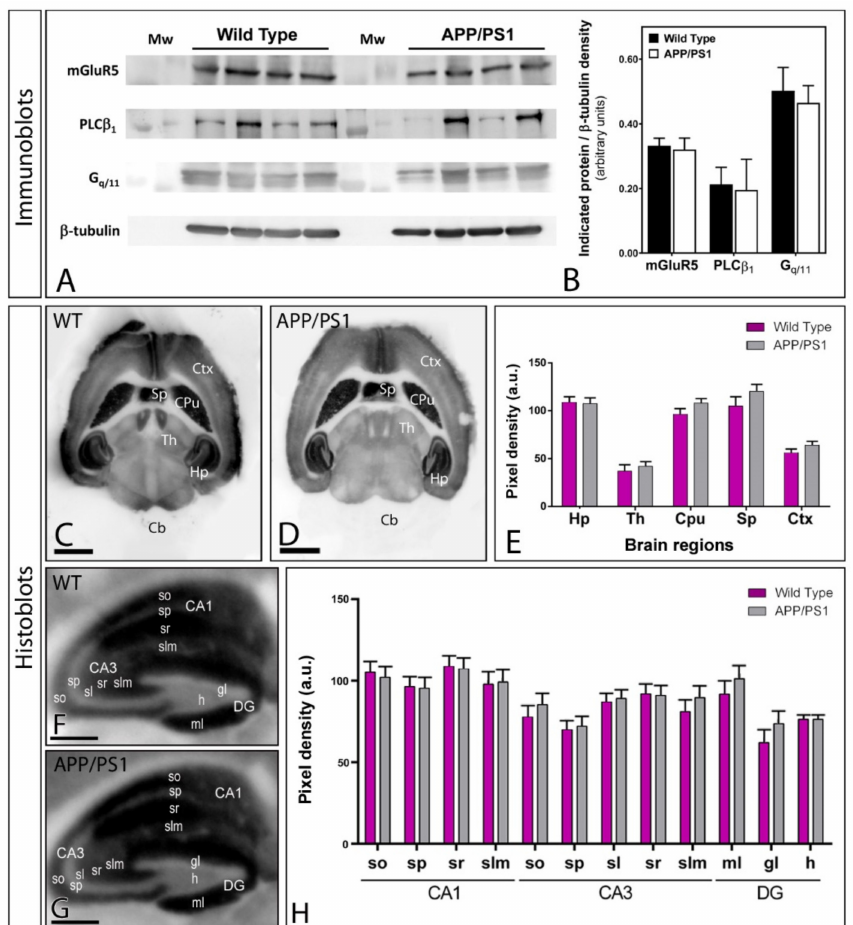
Figure 1. Expression of mGlu 5 in wild type and APP/PS1 mice. ( A , B ) Immunoblots showing the ex- pression of mGlu 5 , PLC β 1 and G q/11 in hippocampal membranes from APP/PS1 and wild type mice at 12 months of age. The developed immunoblots were scanned and densitometric measurements from three independent experiments were averaged together. Quantification of the three proteins were normalised to β -tubulin and expressed as pixel density, showing no differences in APP/PS1 mice compared to age-matched wild type controls. ( C – E ) The regional brain mGlu 5 expression was visualised in histoblots of horizontal brain sections at 12 months of age in wild type and APP/PS1 mice using an affinity-purified anti-mGlu 5 antibody. The expression of mGlu 5 in different brain regions was determined by densitometric analysis of the scanned histoblots. The expression of mGlu 5 revealed marked region-specific differences, with the strongest immunoreactivity in the hippocam- pus (Hp), caudate putamen (CPu) and septum (Sp), and moderate labelling in the cortex (Ctx) and thalamus (Th). The weakest expression level was detected in the cerebellum (Cb). Densitometric analysis showed no differences in mGlu 5 expression in APP/PS1 mice compared to age-matched wild type controls at the ages employed. ( F , G ) Hippocampal expression and distribution of mGlu 5 in wild type and APP/PS1 mice visualised in histoblots of horizontal sections at 12 months of age. ( H ) Expression for mGlu 5 was strong in all dendritic layers of the CA1 and CA3 region and DG, with the strata oriens (so) and radiatum (sr) of the CA1 region showing the highest expression levels. A more moderate expression was observed in the stratum lacunosum-moleculare (slm) of CA1, and the strata oriens (so), radiatum (sr) and lacunosum-moleculare (slm) of CA3, with the molecular layer (ml) and hilus (h) of the DG showing the lowest expression level. Densitometric analysis showed no differences in mGlu 5 expression in APP/PS1 mice compared to age-matched wild type controls. Error bars indicate SEM. Scale bars: ( C , D ), 0.2 cm; ( F , G ), 0.05